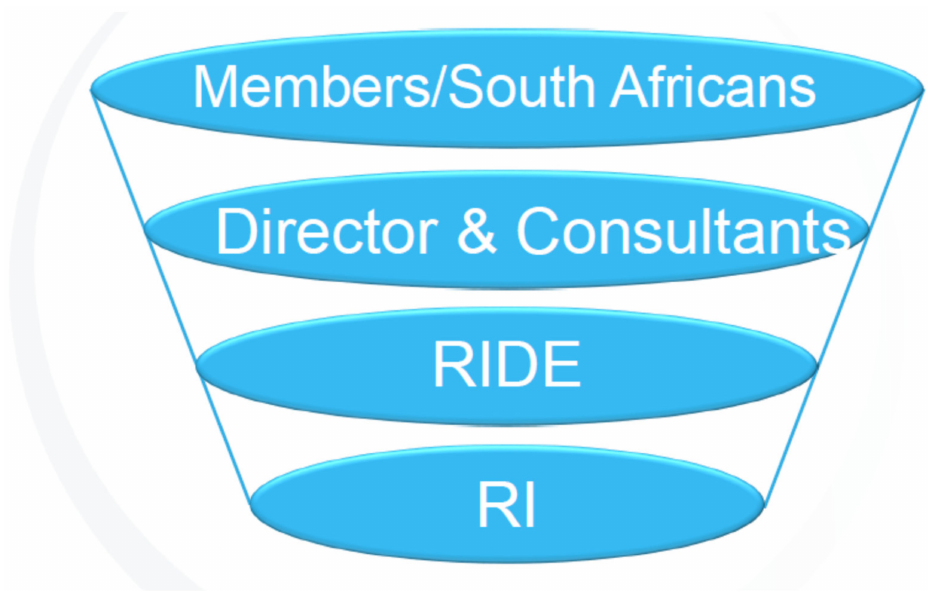
Figure 2. Containment of diversity dynamics